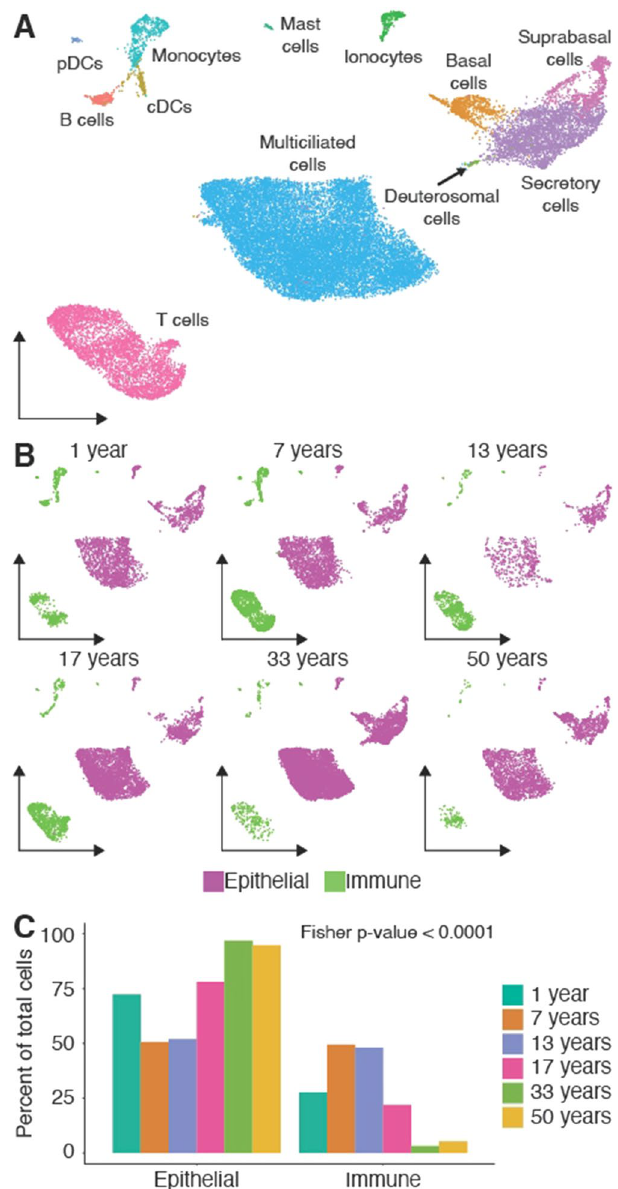
Figure 1. Immune cell residency decreases with age in the nasal mucosa. ( A ) UMAP projection of cells from nasopharyngeal swabs collected across the lifespan pools. Colors correspond to different cell types. ( B ) Same UMAP projection from A split by the 6 pools that make up the dataset. Cells are colored by a coarse cell type assignment where magenta cells are epithelial, and green cells are immune. ( C ) Bar plot quantification of B. p -values is for a Fisher’s exact test of association between age and cell type